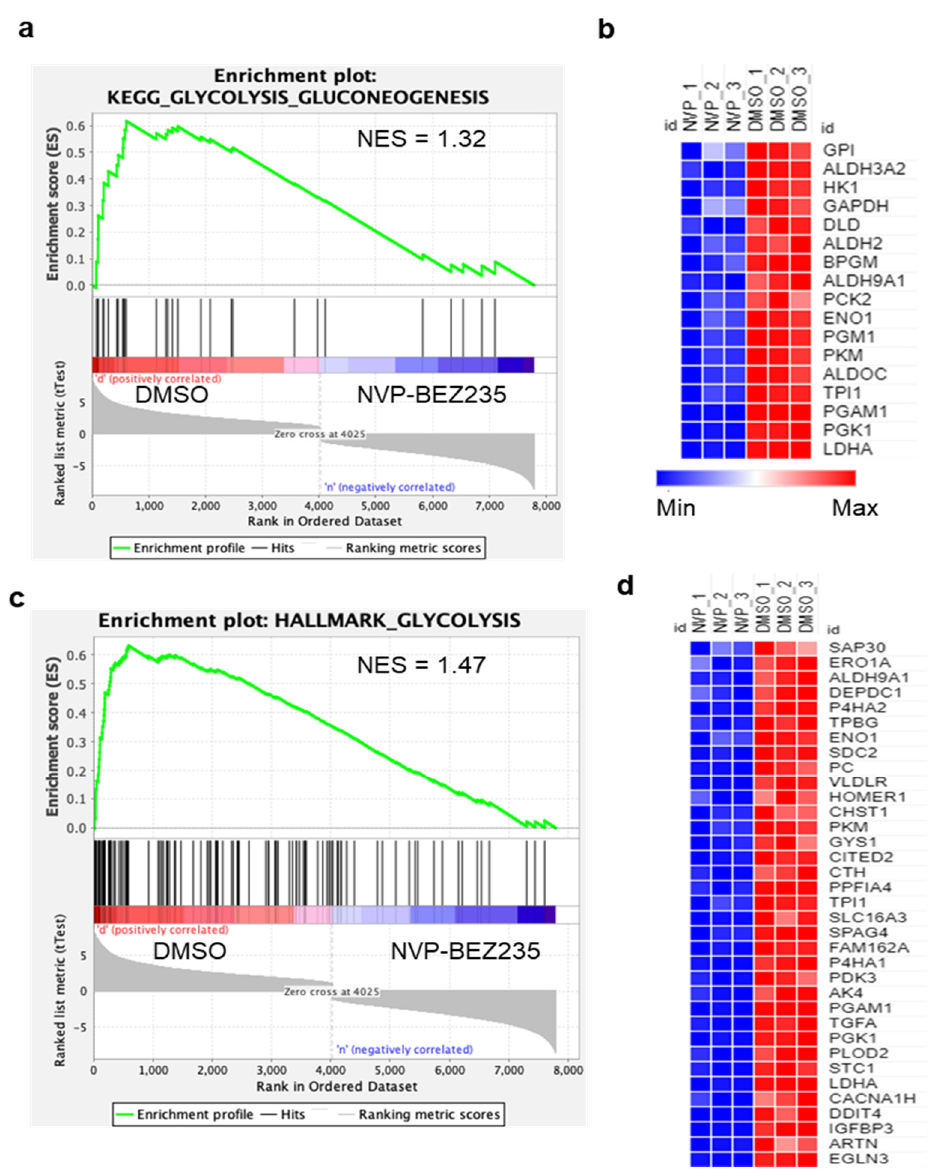
Figure 1. Glycolytic genes are reduced by NVP-BEZ235 treatment in U87MG cells. GSEA generated enrichment plots and generated heatmaps depicting the enrichment of sample phenotypes, control (DMSO) and NVP-BEZ235-treated (50 nM for four days in U87MG cells), in priori defined glycolysis gene sets. ( a ) KEGG glycolysis gluconeogenesis gene set, ( b ) heatmap of 17 core enriched genes KEGG_GLYCOLYSIS_GLUCONEOGENESIS gene set ( c ), Hallmark glycolysis gene set, ( d ) heatmap of 35 core-enriched genes in HALLMARK_GLYCOLYSIS gene set. The profile of enrichment score (ES) and rank ordered list for enriched genes are shown. Both gene sets were significantly enriched in control samples compared to NVP-BEZ235 treatment samples p < 0.05.